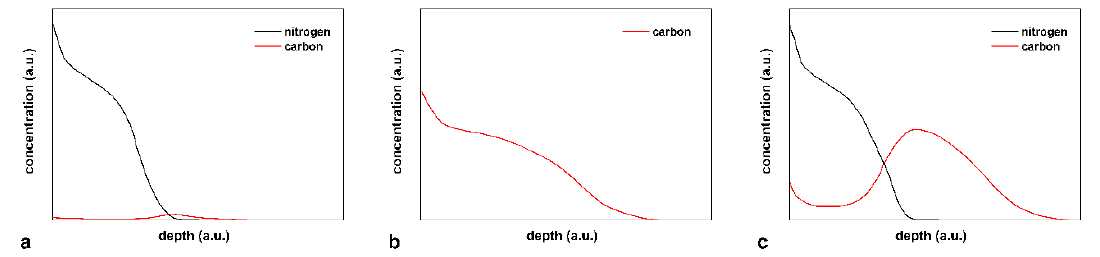
Figure 1. Qualitative N and/or C profiles vs. depth: ( a ) nitrided (as in ref. [42,55,59]); ( b ) carburized (as in ref. [42,55]); ( c ) nitrocarburized (as in ref. [42,55,56,60]) austenitic stainless steels.